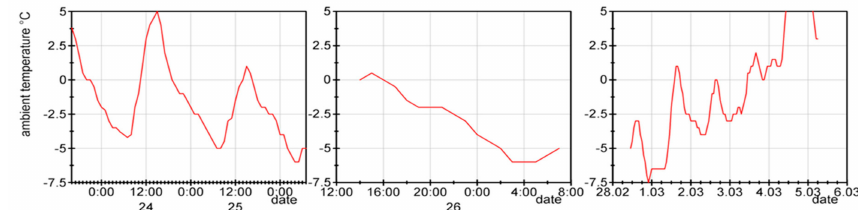
Figure 8. Temperature during outdoor freezing: 1st freezing cycle, 46 h of 64 h at subzero temperatures ( left ); 2nd freezing cycle, 15 h of 18 h at subzero temperatures ( middle ); 3rd freezing cycle, 66 h of 116 h at subzero temperatures ( right ).